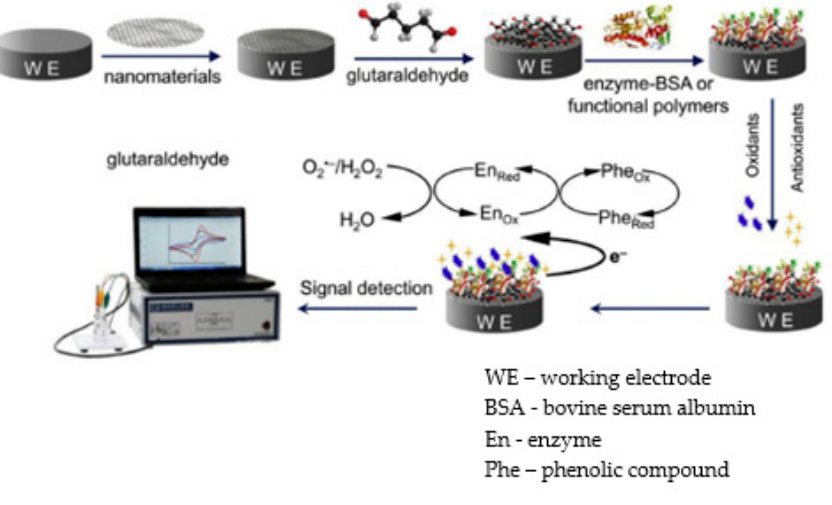
Figure 2. The schematic representation of developing a modified electrode based on enzymes. Pub- lished from [102] with the permission of the publisher.